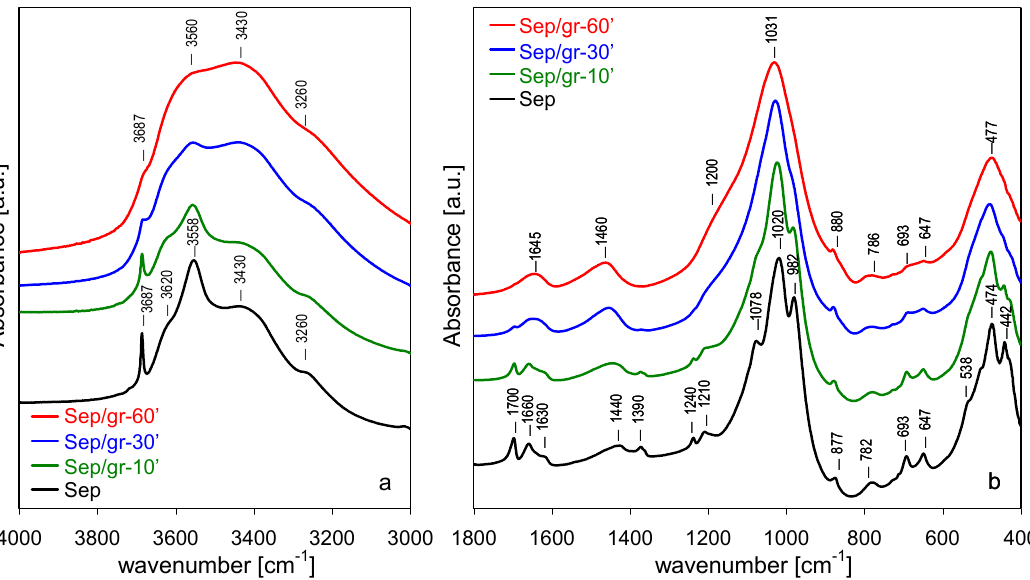
Figure 5. Evolution of FTIR spectra for sepiolite ground for di ff erent periods: ( a ) 3000–4000 cm − 1 , ( b ) 400–1800 cm − 1 .